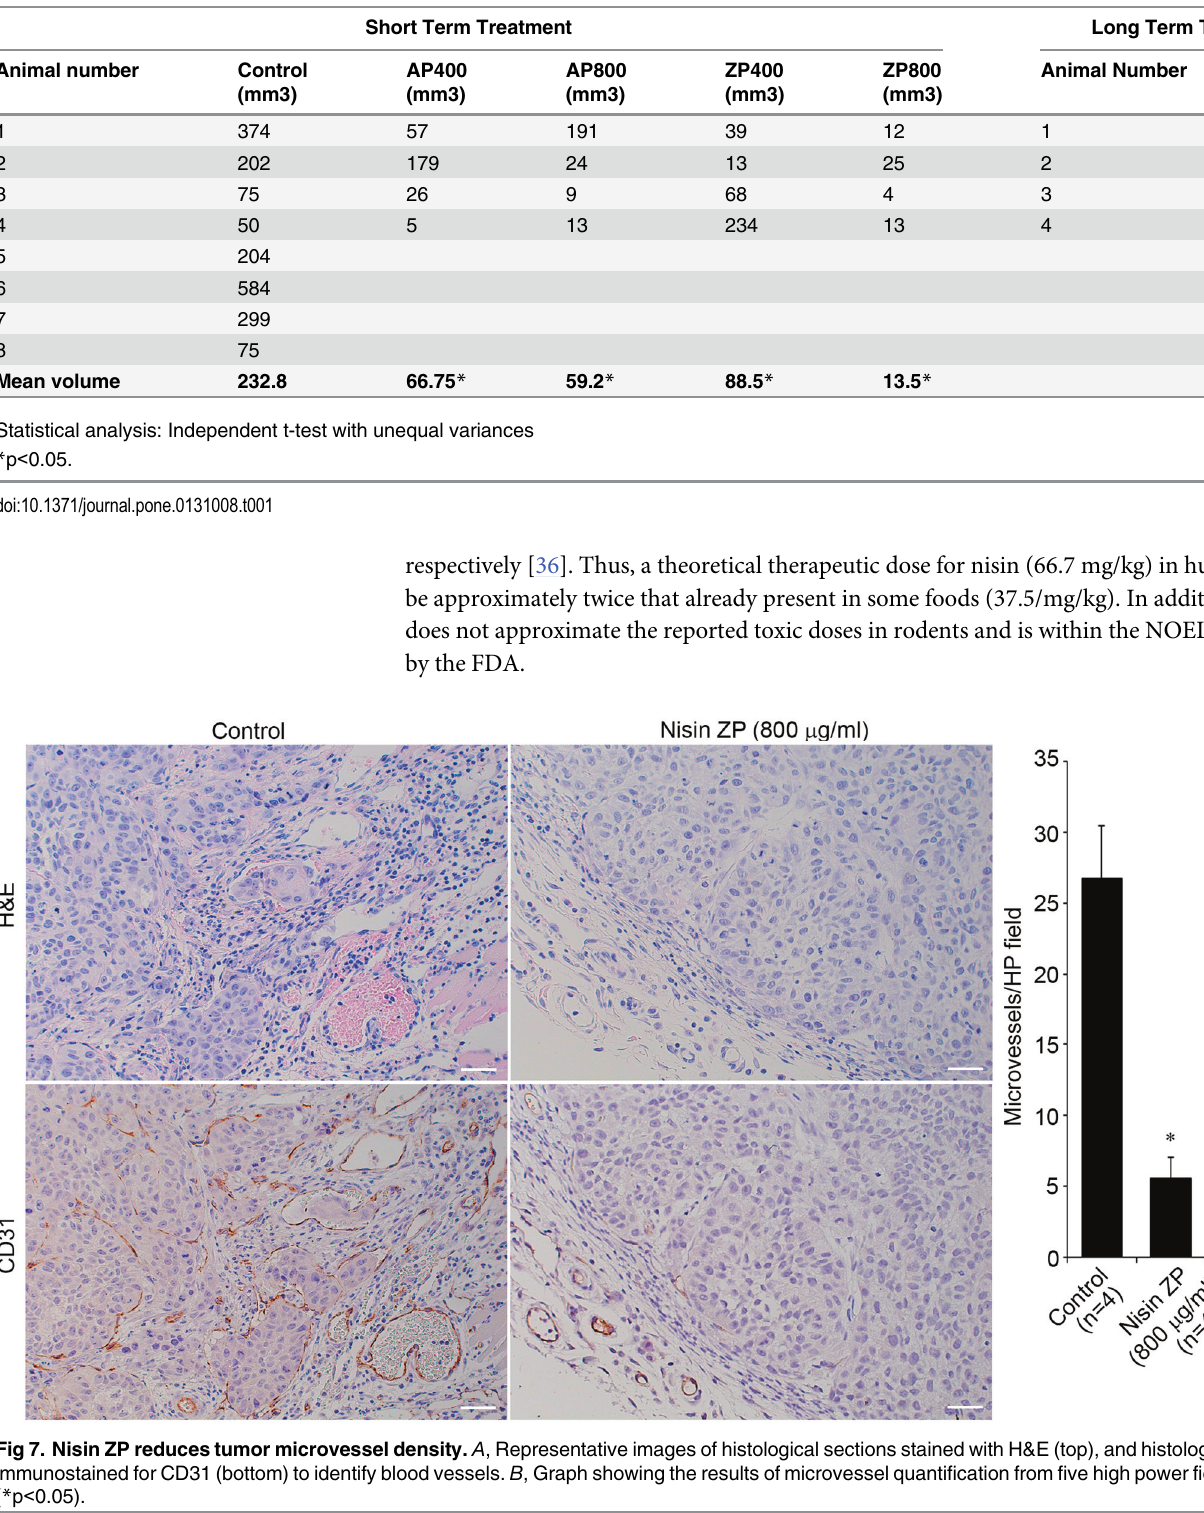
Table 1. Tumor volumes for mice injected with UM-SCC-17B cells then treated with water (control) or nisin (400 or 800 mg/kg body weight/day), using a short term (3 weeks) or long term treatment approach (9 weeks).